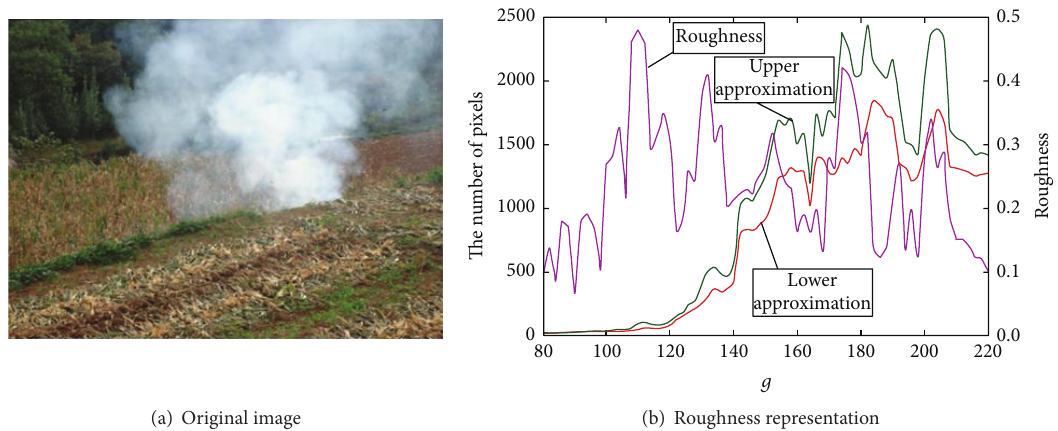
Figure 2: Roughness representation of color